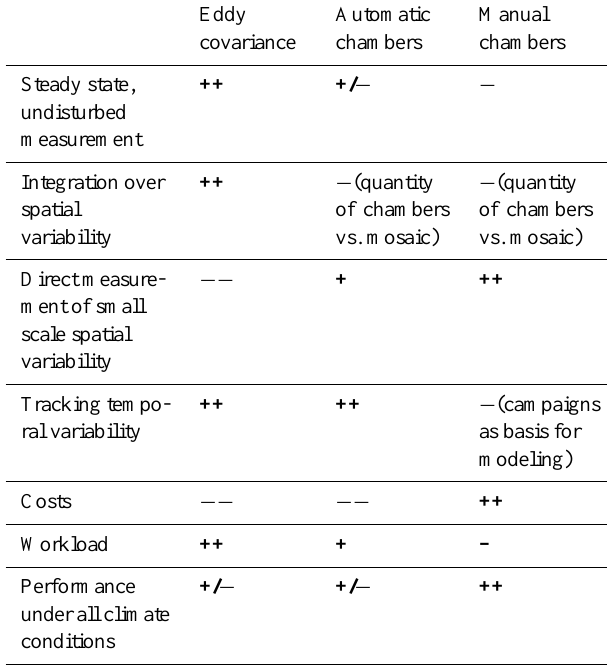
Table 1. A summary of the technical performance different flux measurement techniques. ++ means high performance, + means ad- equate performance, − means less than adequate performance, and −− means poor